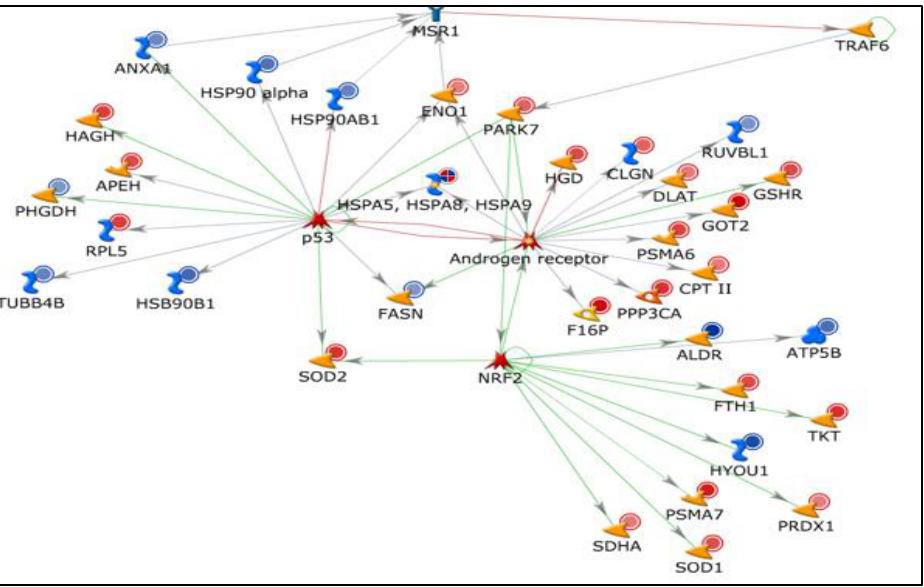
Figure 2. Transcription factors androgen receptor, p53, and NRF2 affected by the differential expression of proteins involved in the acetylation process.